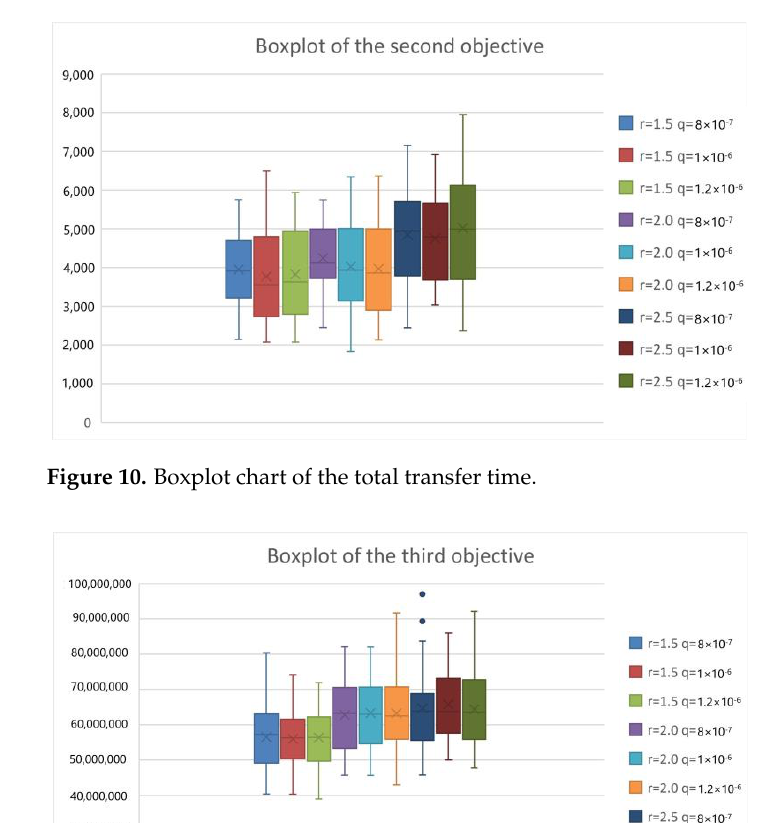
Figure 9. Boxplot chart of the total number of untreated infected patients.